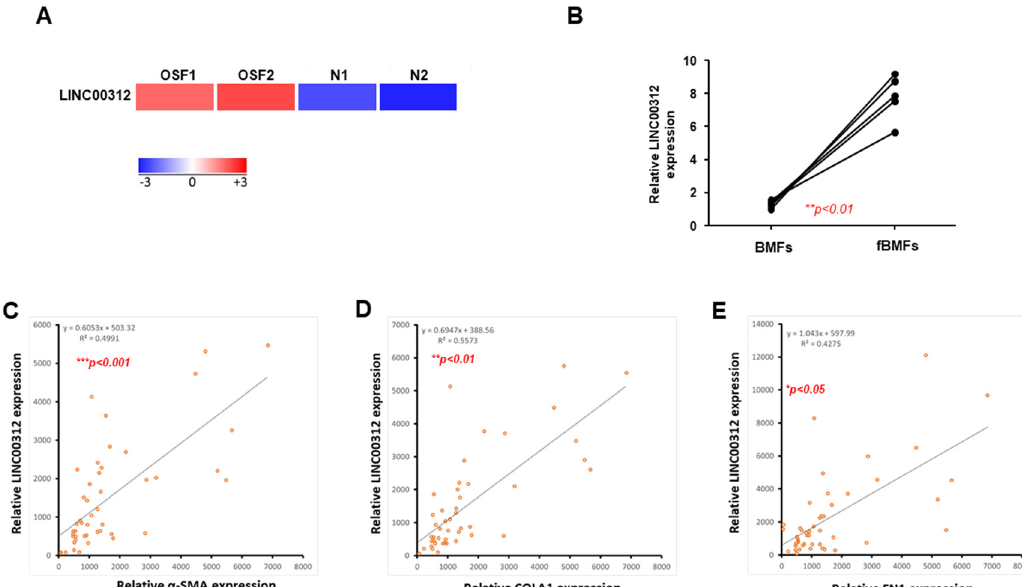
Figure 1. The expression of LINC00312 is upregulated in oral submucous fibrosis (OSF) tissues and positively correlated with fibrosis markers. ( A ) RNA-seq analysis revealed that LINC00312 was overexpressed in OSF tissues compared to the normal buccal mucosa. ( B ) The relative expression level of LINC00312 were higher in human fibrotic buccal mucosal fibroblasts (fBMFs, n = 5) relative to human normal buccal mucosal fibroblasts (BMFs, n = 5). The expression of LINC00312 was positively correlated with ( C ) ACTA2 ( α -SMA), ( D ) COL1A1 (alpha 1 type I collagen), and ( E ) FN1 (fibronectin) expressions in OSF samples from using qRT-PCR and Pearson’s correlation coefficient.